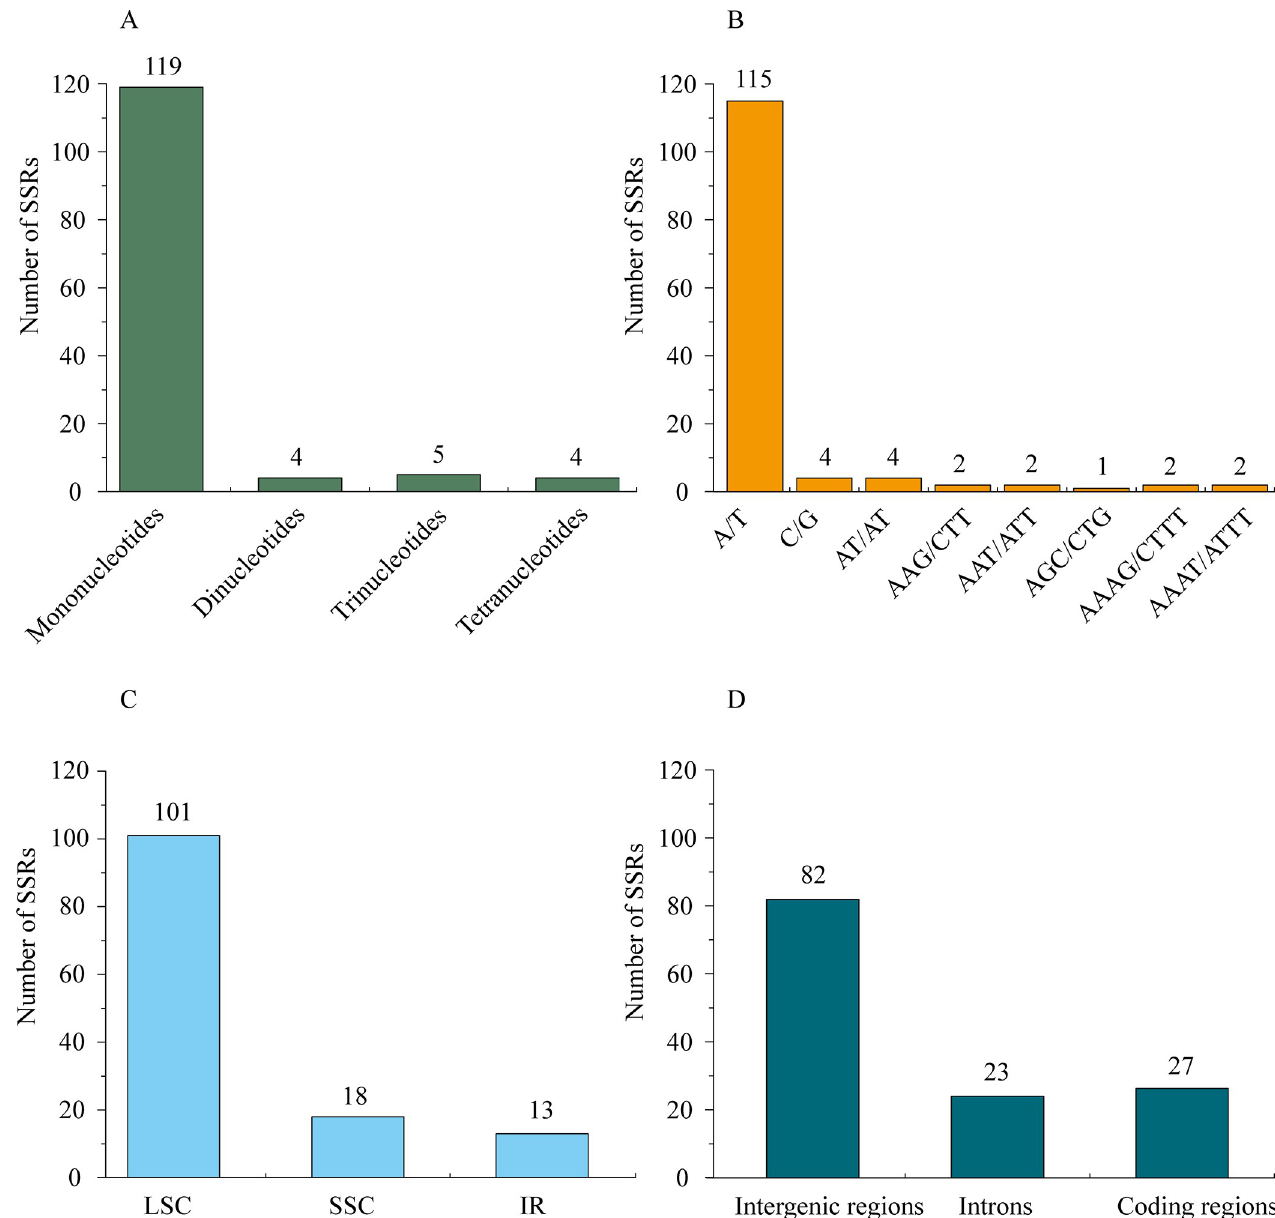
Fig 2. Distribution of SSR Types in I . dabieshanensis chloroplast genome. A) Number of SSRs detected; B) Number of identified SSRs in different repeat class types; C) Number of identified SSRs in different genomic regions; and D) Number of identified SSRs in intergenic regions, introns, and coding regions.